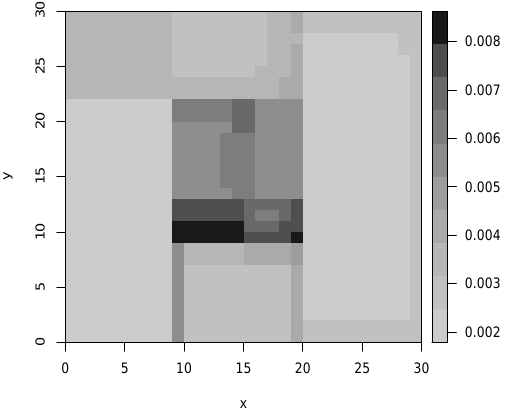
Figure 5. Map of the standard error (Example